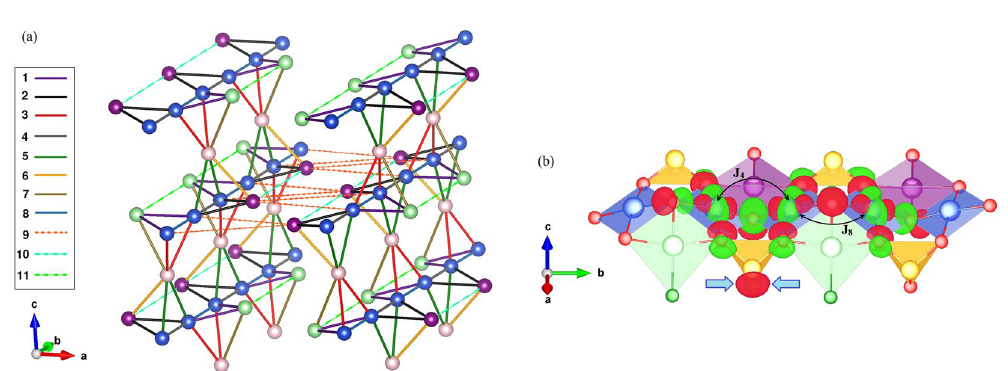
Figure 5. (Left panel) Band structure of KCu 5 O 2 (SeO 3 ) 2 Cl 3 near the Fermi level calculated on the GGA level. The green dotted lines denote the results of the GGA calculation, whereas the blue lines correspond to a minimal tight-binding model constructed in the Wannier function basis. (Right panel) Corresponding atomic- resolved densities of states (DOS).